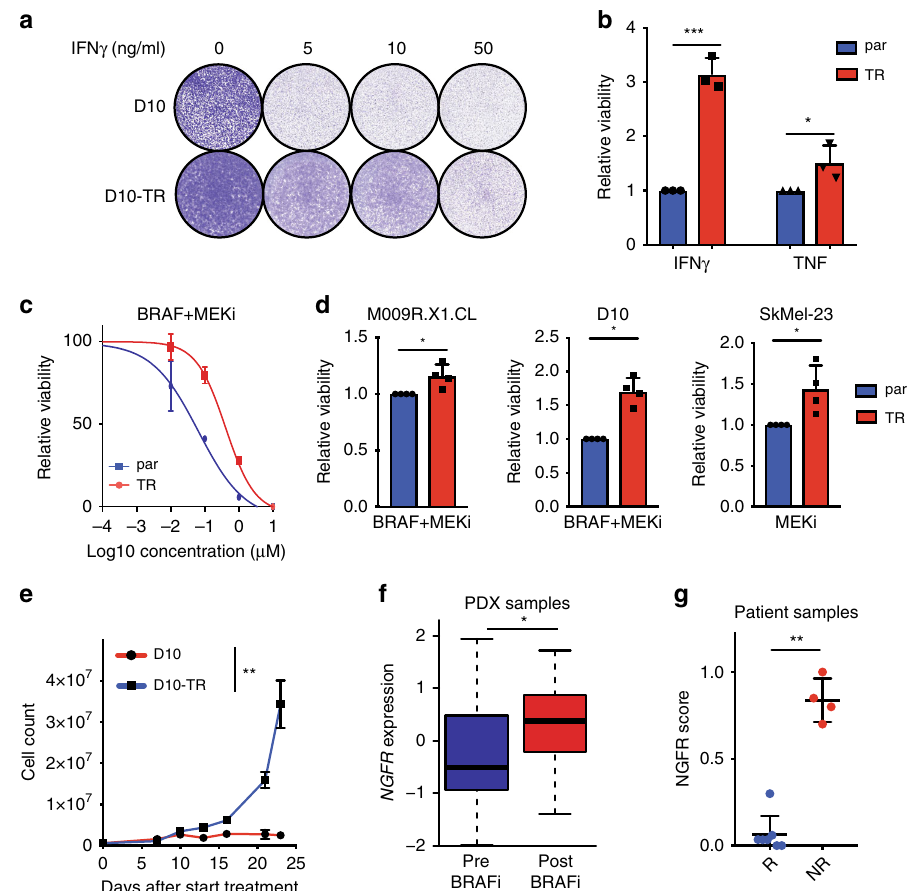
Fig. 2 NGFR hi melanomas are resistant to multiple therapies. a Colony formation assay on IFN γ treatment on D10 and D10-TR cells. Tumor cells were treated for 7 days with IFN γ (which was refreshed on day 4) and stained with crystal violet. Quanti fi cation in b . b Quanti fi cation of IFN γ and TNF treatment for 7 days on D10 and D10-TR cells (medium was refreshed on day 4). Error bars represent S.D. of three independent replicates. Statistical analysis by unpaired t -test; * p < 0.05, *** p < 0.001. c Cytotoxicity assay in D10 parental versus TR cells for BRAF + MEKi. Titrations were performed with a 10:1 ratio of BRAFi:MEKi concentration. Error bars represent S.D. of three biological replicates; the experiment was performed in four independent replicates (as quanti fi ed in d ). d Quanti fi cation of three cell lines for BRAF/MEKi sensitivity in parental versus TR lines. BRAF inhibitor dabrafenib was given at 10 nM and MEK inhibitor trametinib at 1 nM. Error bars represent S.D. of four independent replicates. Statistical analysis by Mann – Whitney test; * p < 0.05. e Cell count in parental and TR cells of the D10 cell line, treated continuously with 1000nM of dabrafenib. Error bars represent S.D. of two independent replicates. Statistical analysis by Mann – Whitney test; * p < 0.05. f Average NGFR expression in PDX samples from melanoma. Error bars represent S.D. Statistical analysis by unpaired t -test. * p < 0.05. g NGFR immunohistochemistry score for patient samples prior to and on BRAF + MEK inhibition, divided in responders (R) and nonresponders (NR). Statistical analysis by Mann – Whitney, ** p < 0.01. Source data are provided as a Source Data fi